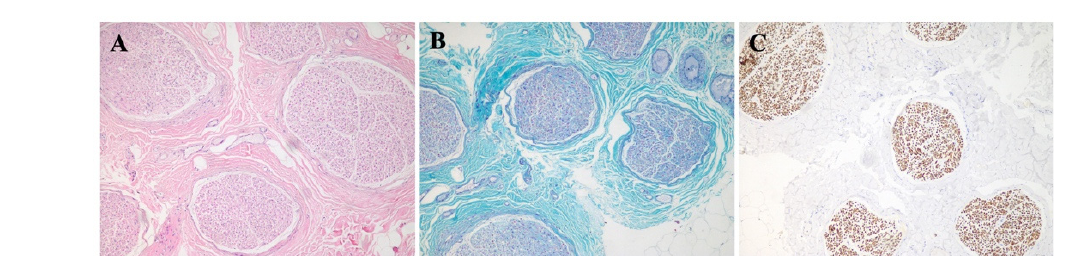
A nerve biopsy of the left sural nerve showed no obvious abnormality in the density of myelinated nerve fibers, and no significant demyelination (Figure 2A–C).